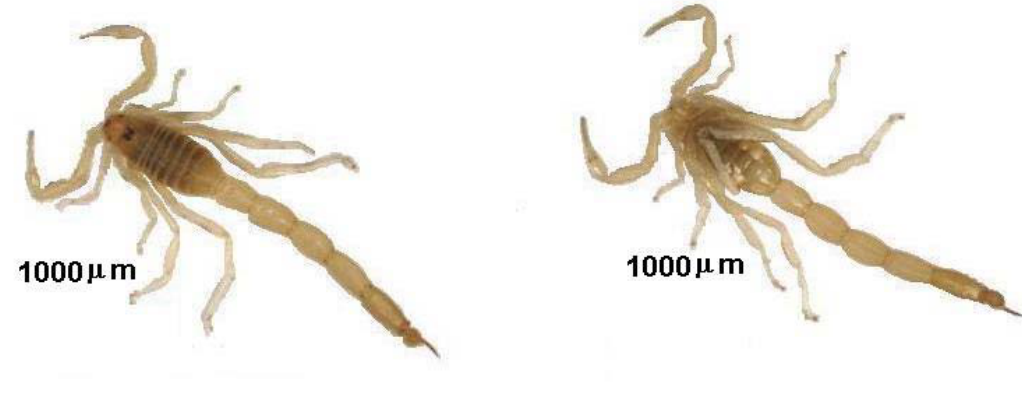
Figure 9. Buthacus leptochelys collected in the Riyadh